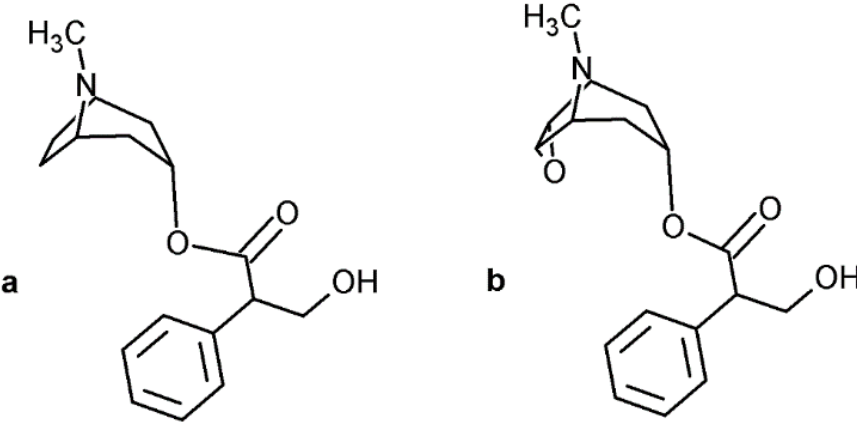
Figure 1. Chemical structure of atropine ( a ) and scopolamine ( b